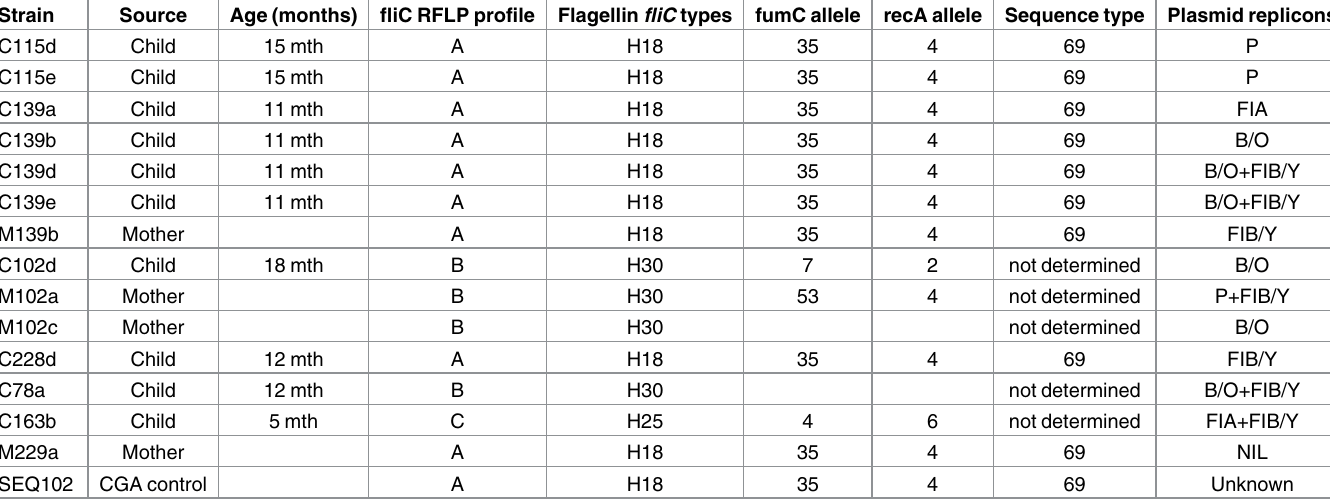
Table 5. Plasmid replicon, fliC restriction types and sequence types of dfrA17-aadA5 isolates. Strain